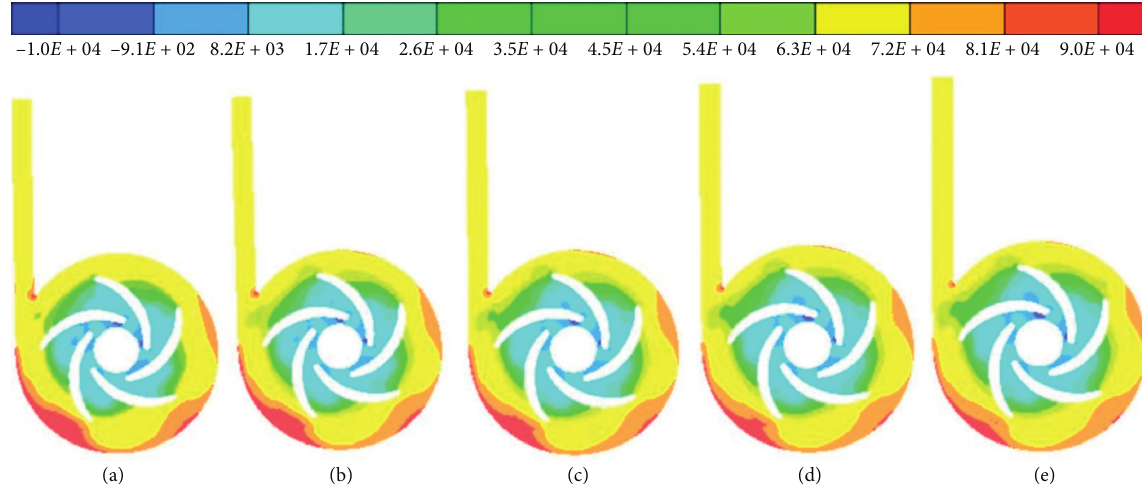
Figure 5: Cloud diagram of centrifugal pump pressure with different particle sizes ( C (d) 0.15mm, and (e) 0.2mm.